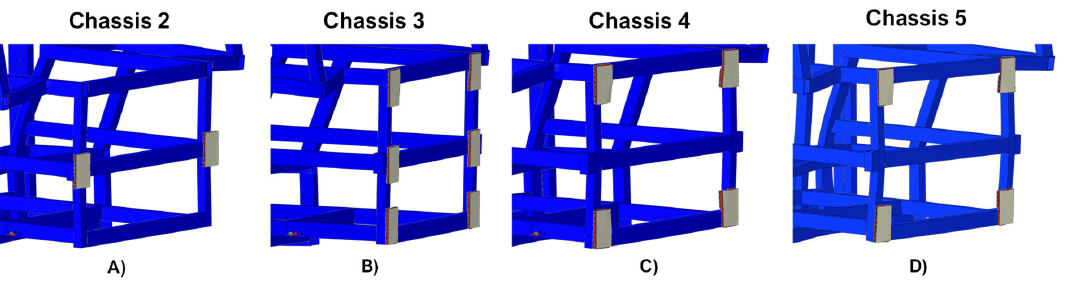
Figure 11. Chassis-damping systems interaction zone after crash tests. ( A ) Chassis 2; ( B ) Chassis 3; ( C ) Chassis 4; ( D ) Chassis 5.